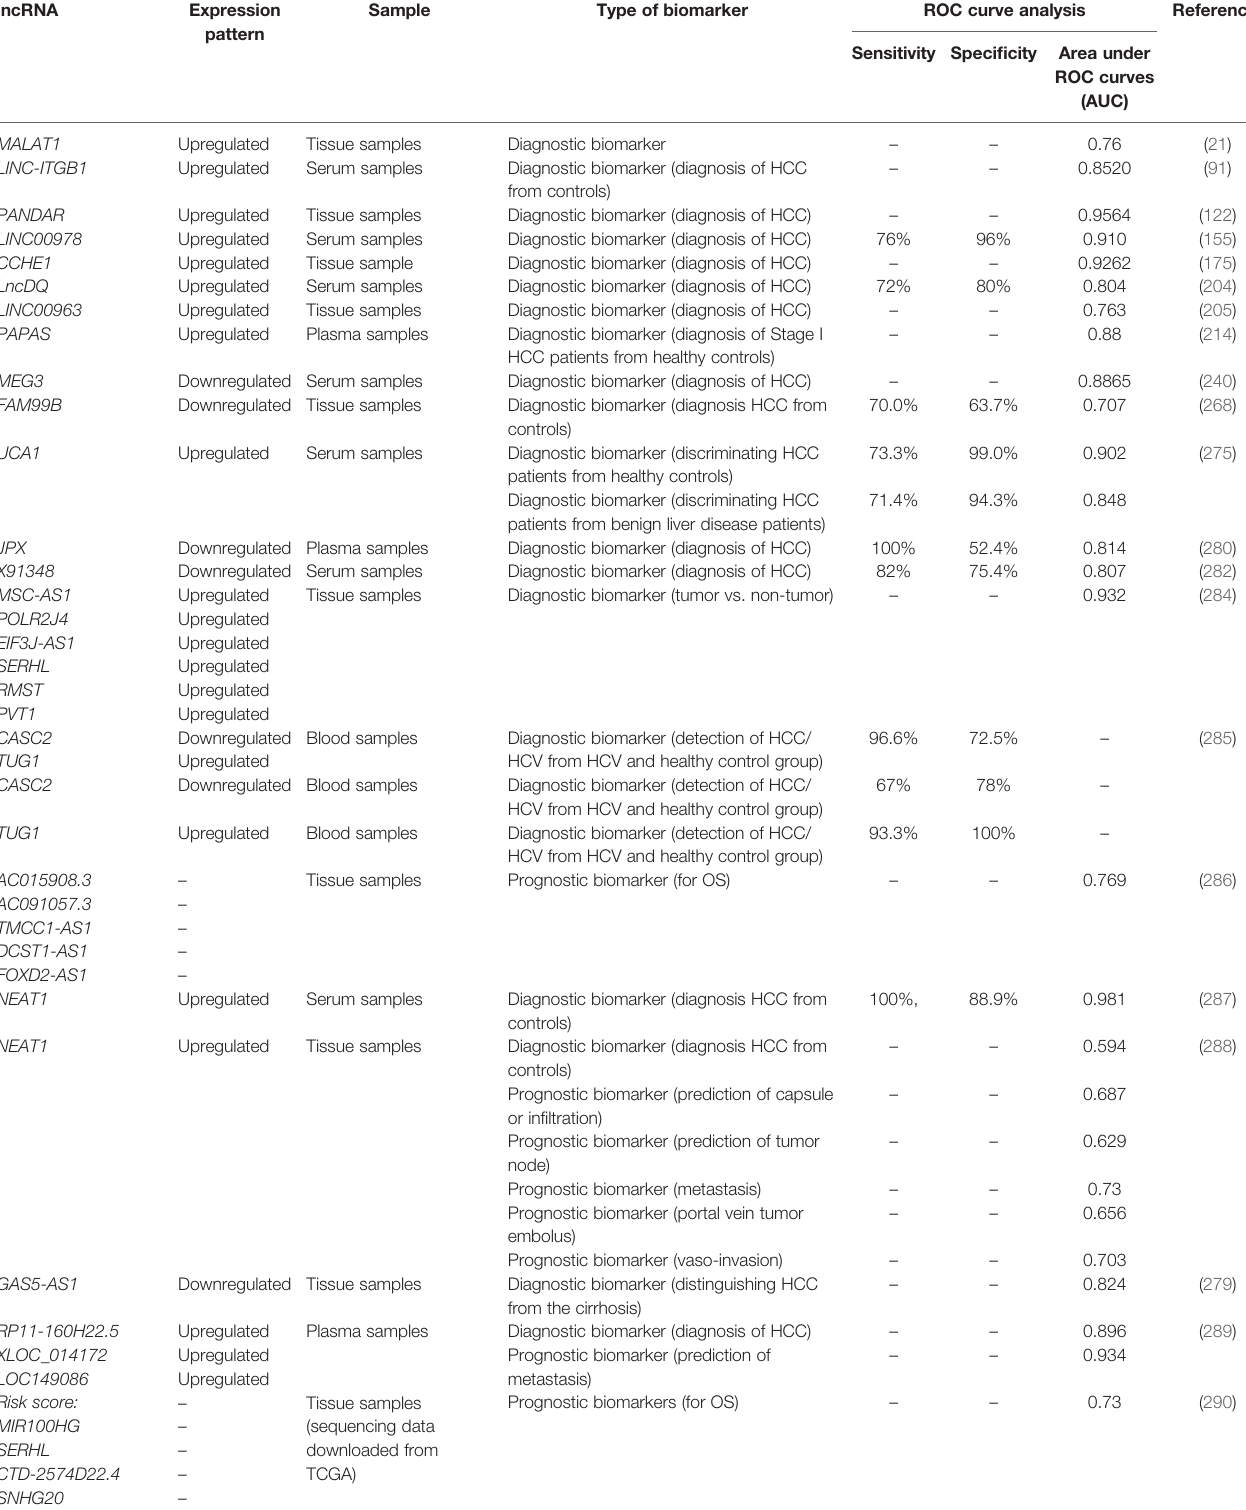
TABLE 4 | Diagnostic role of lncRNAs in